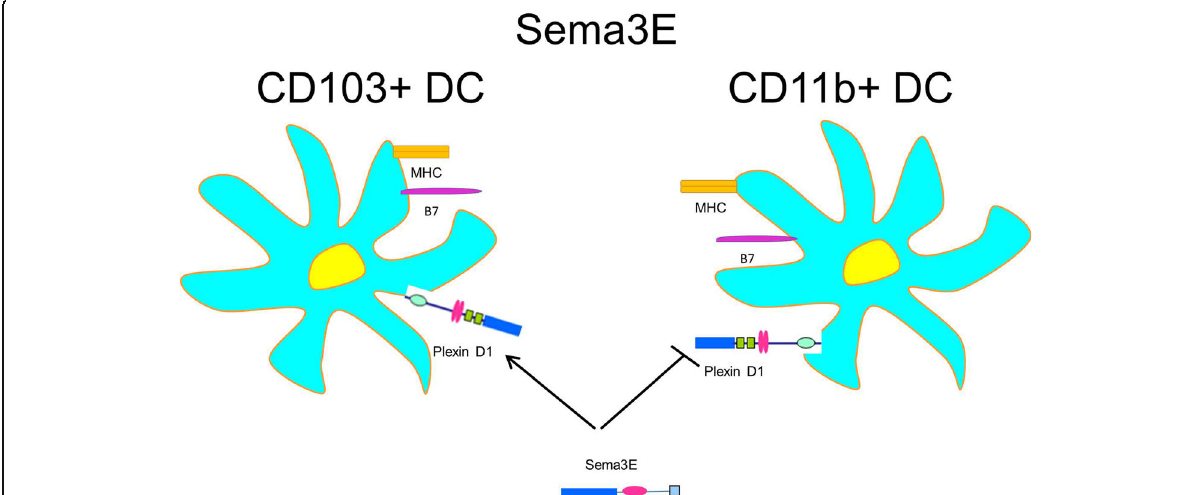
Fig. 2 Sema3E regulates DC subsets. Higher numbers of CD11b + DC and lower numbers of CD103+ DC were detected in the lungs of Sema3E − / − mice at the steady-state condition and after allergen sensitization. The DC receptor involved in such Sema3E action is Plexin